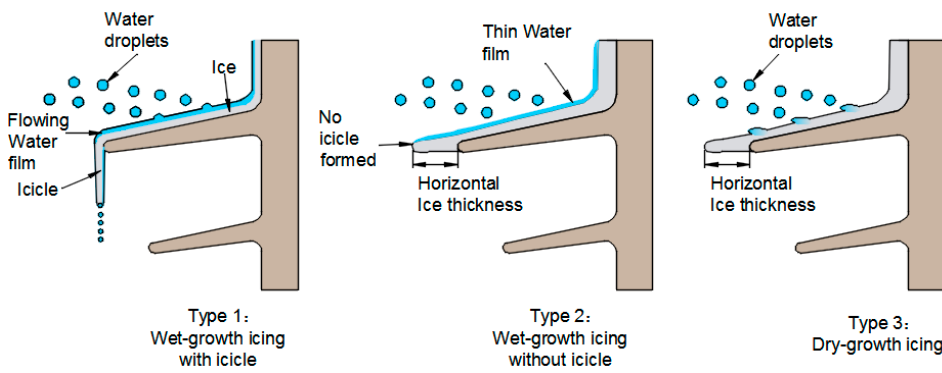
Figure 5. Three types of icing on insulator.